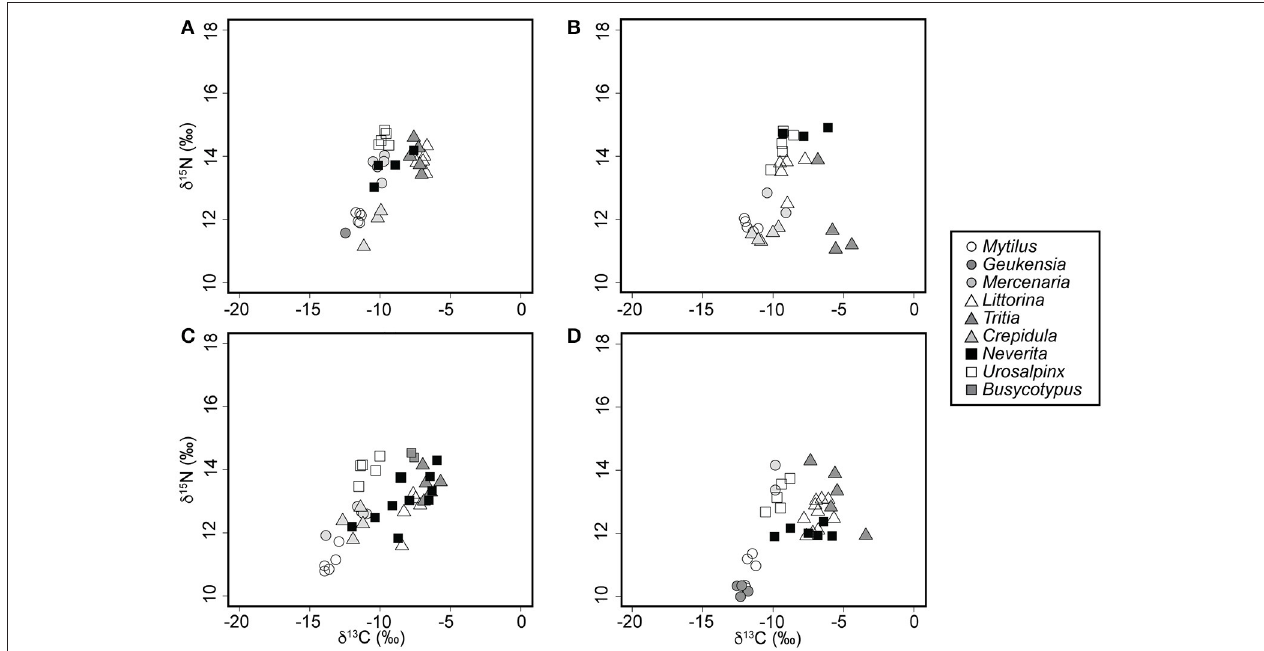
FIGURE 3 | Whole-body nitrogen and carbon signatures of field-collected mollusks sampled during the summer of 2008. (A) Rye, NY. (B) Bridgeport, CT. (C) Milford, CT. (D) Guilford, CT.